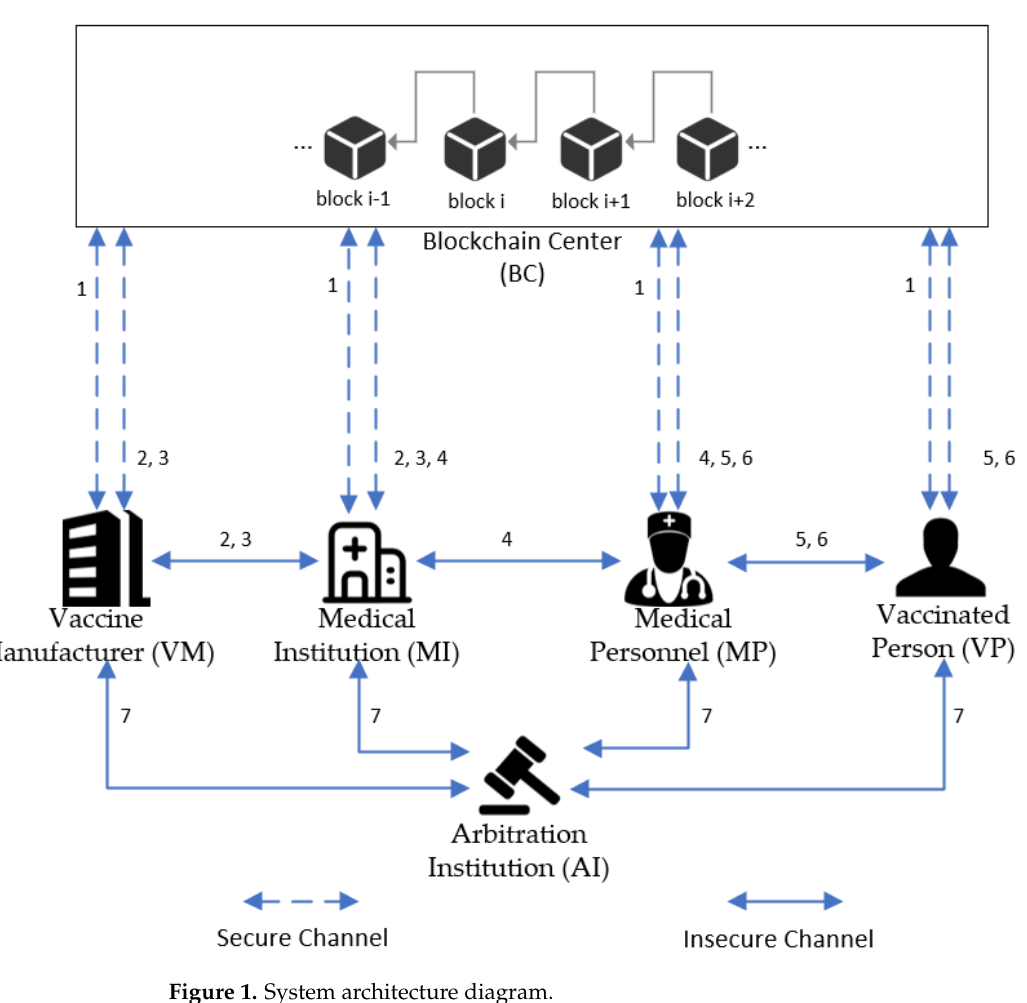
Figure 1. System architecture diagram.